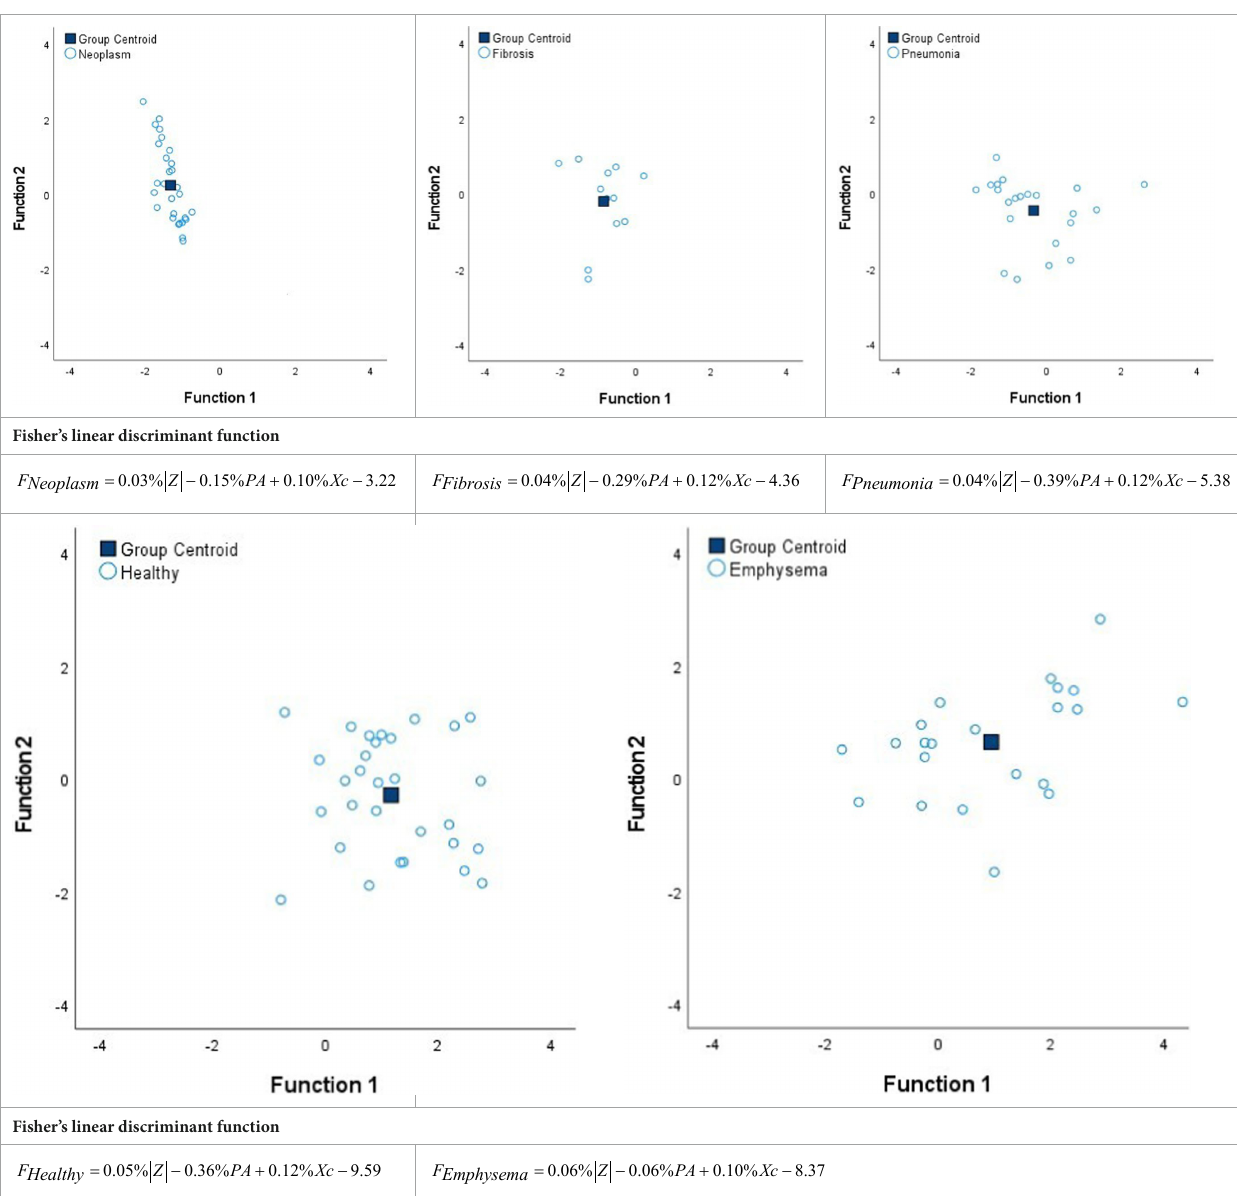
TABLE 4 Fisher’s linear discriminant functions for neoplasm, fibrosis, pneumonia, healthy and emphysema lung bioimpedance samples and canonical discriminant functions for the bioimpedance parameters (|Z|, PA and Xc).